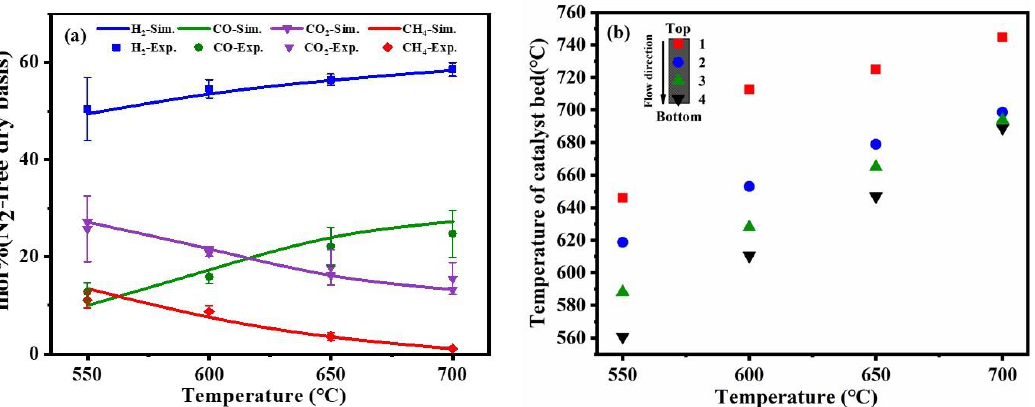
Figure 3. Comparison of experimental results and simulation results at different temperatures ( a ), the different temperature distribution in the catalyst bed ( b ) (reaction condition: the flow rate of toluene = 0.2 mL/min, the flow rate of water = 0.31 mL/min, the flow rate of dry air = 317.4 mL/min).